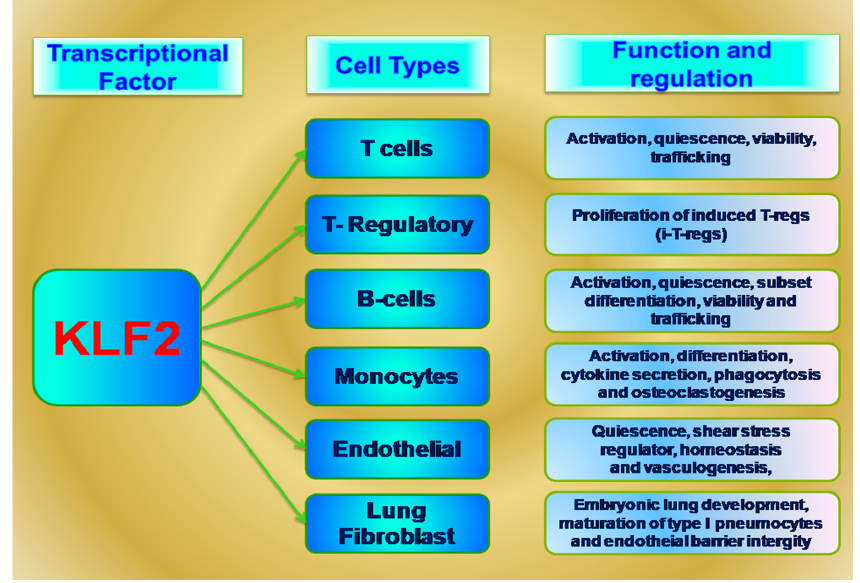
Figure 1. Kruppel-like factor 2 (KLF2) mediated functions in various cell types.